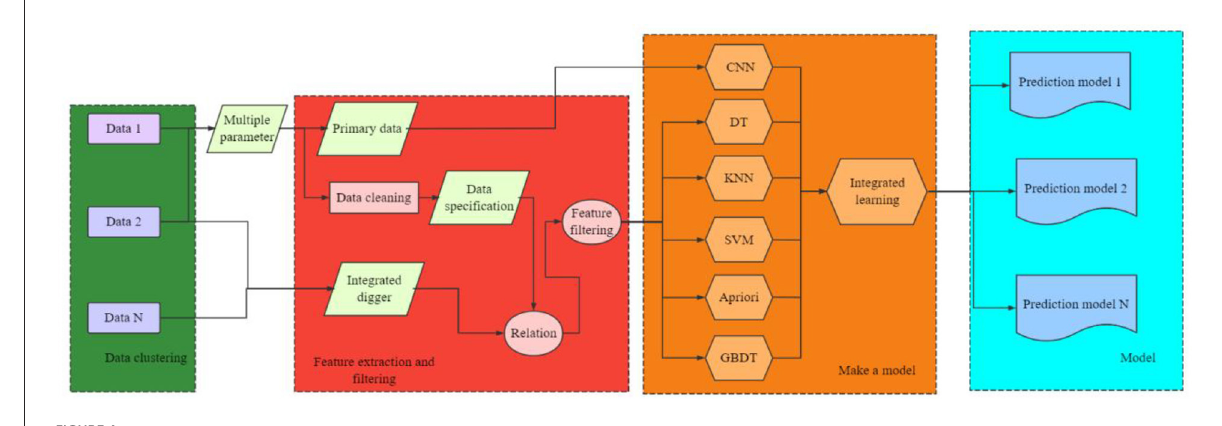
FIGURE4 Business process of PD data mining system for college